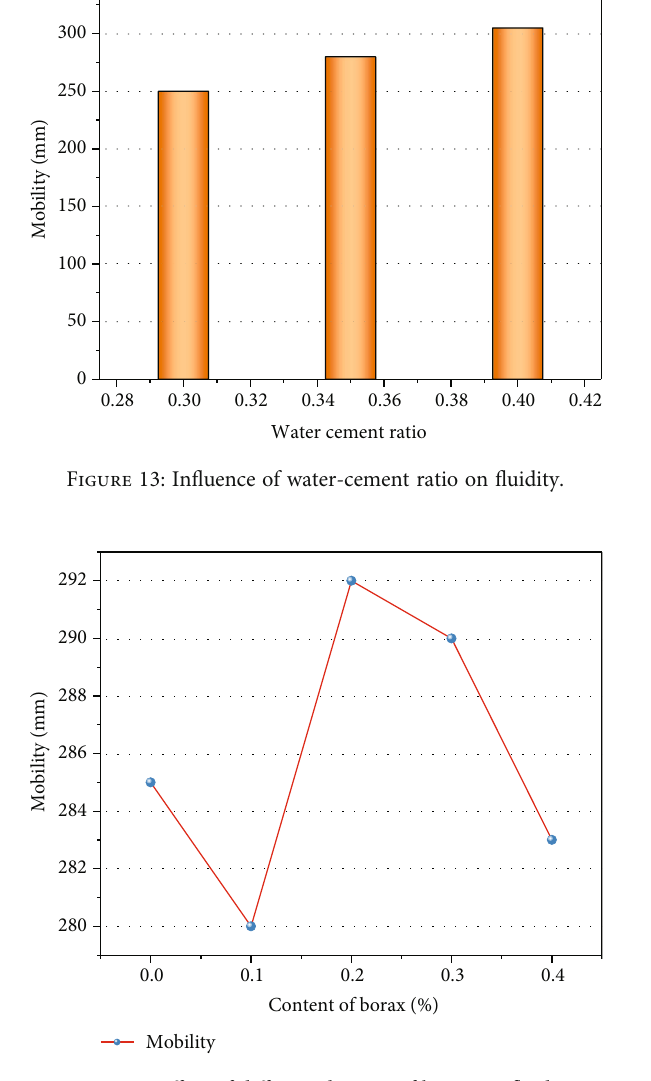
Figure 14: E ff ect of di ff erent dosages of borax on fl uidity.